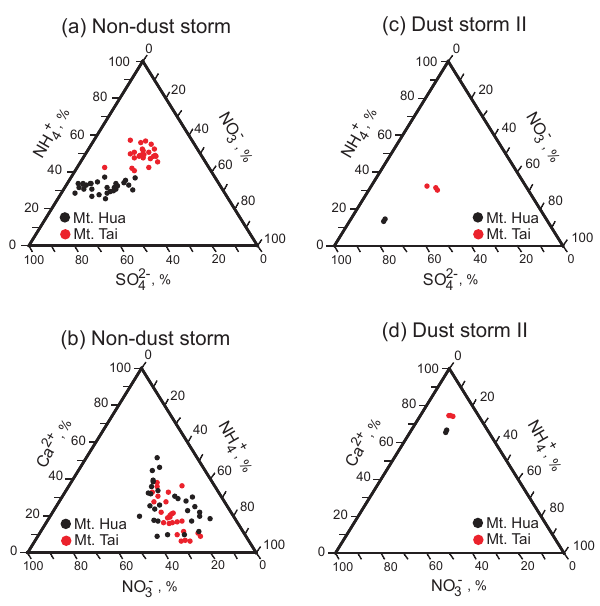
Fig. 9. Ternary diagrams for the equivalent ratio of major ions in PM 10 samples during (a) , (b) the non-dust and (c) , (d) the dust storm II